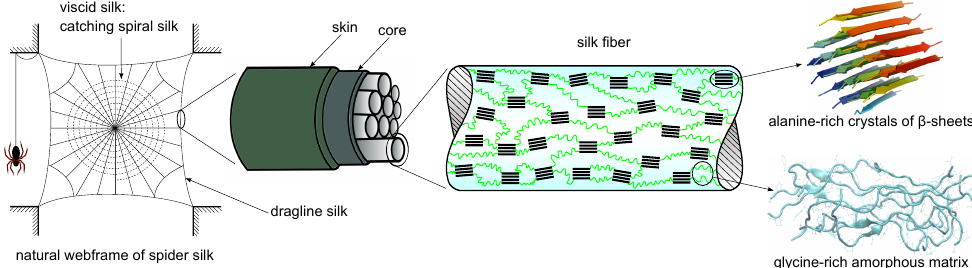
Figure 1. Illustrative representation of the spider dragline silk fiber architecture, highlighting the catching spiral silk (dotted black line), and the much dragline silk. Dragline silk fibers are mainly constituted of alanine-rich stiff and strong nano-crystals of β -sheets in the glycine-rich randomly disordered peptide